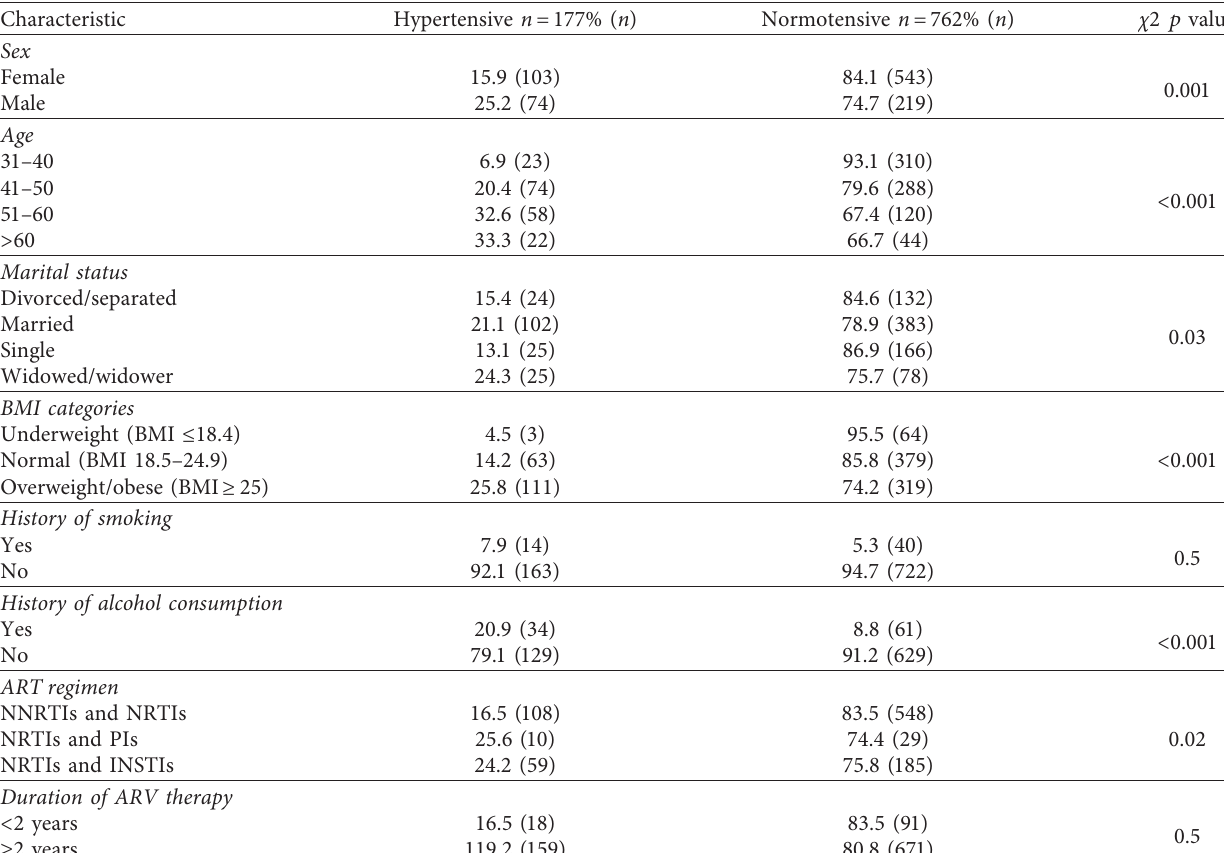
Table 2: Bivariate associations of patients’ characteristics versus hypertension among HIV